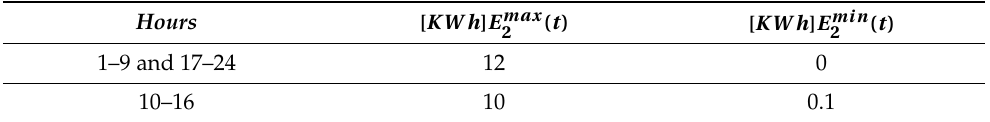
Table 4. A sample maximum and minimum allowable energy consumption for a commercial